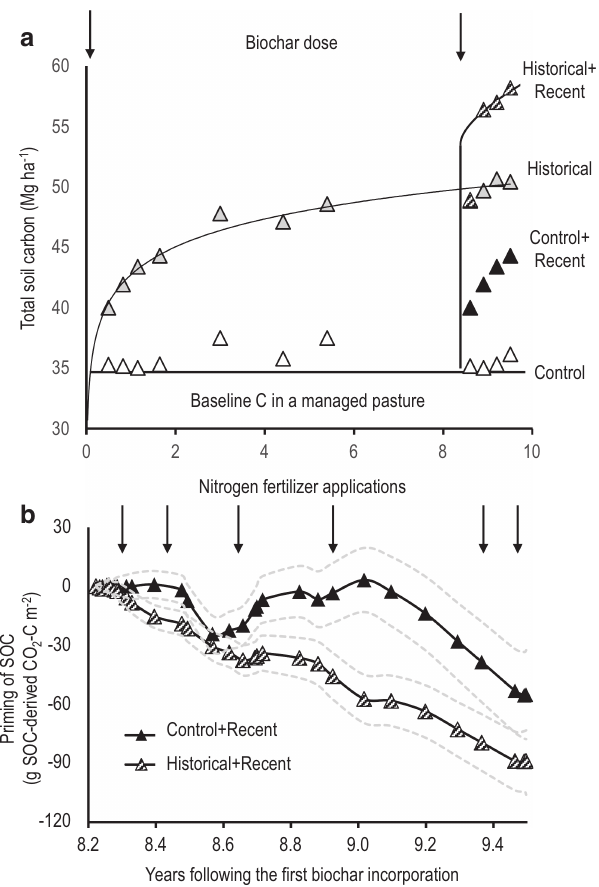
Fig. 2 | Belowground carbon dynamics in a long-term continuous biochar fi eld experiment. a Changes in total soil organic carbon (SOC, Mg C ha − 1 ) in the 0 – 75mm soil layer of the Control and biochar-amended soils over 9.5y ( n =3, LSD=1.1). b Rhizosphere priming, shown as the difference in cumulative SOC mineralization between planted and unplanted systems of Control+Recent and Historical+Recent soils. Shaded regions in b represent 95% con fi dence intervals normalized against the mean squares across both treatments at each sampling event ( n =3). Con fi dence intervals were based on a sensitivity analysis that con- siders the extreme scenarios of contrasting SOC pools (C 3 vs. C 4 -dominated) by differences in δ 13 C soil